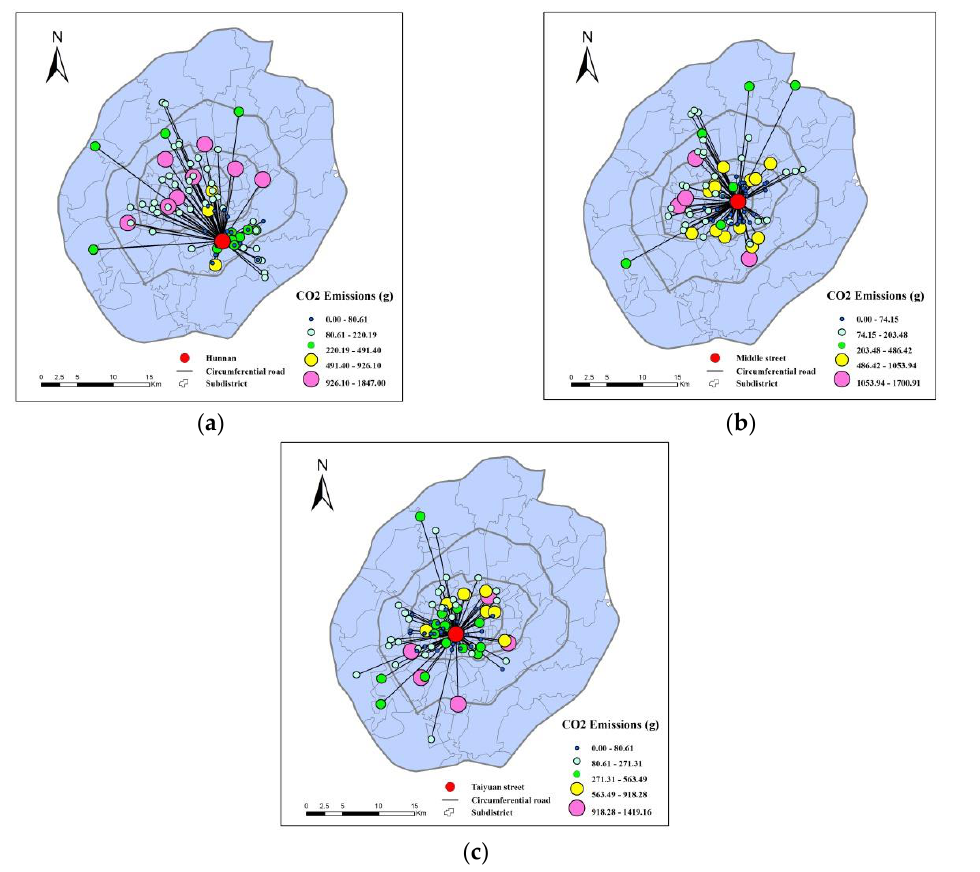
Figure 4. ( a ) CO 2 emissions per trip to Hunnan; ( b ) CO 2 emissions per trip to Middle Street; and ( c ) CO 2 emissions per trip to Taiyuan Street.